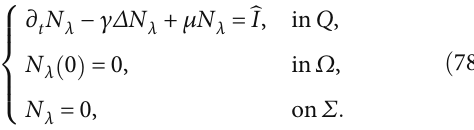
Figure 3: One section and 3-dimensional plot for the proportion infective persons capable of transmitting the COVID-19 to persons at risk in space and